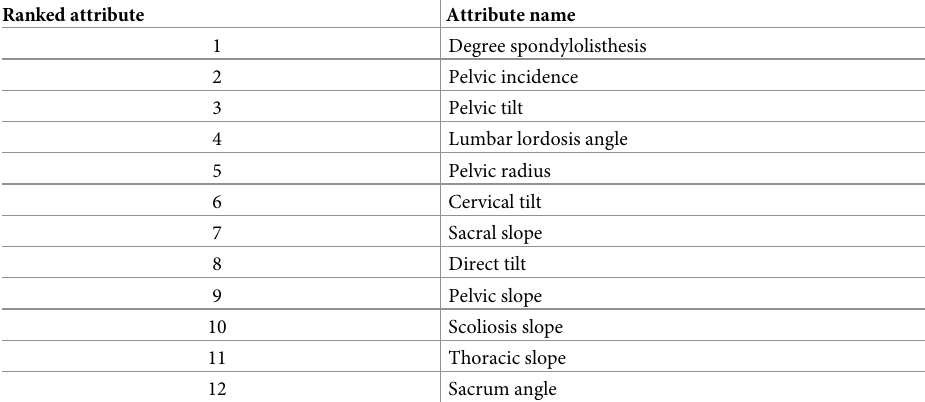
Table 2. Feature name and associated